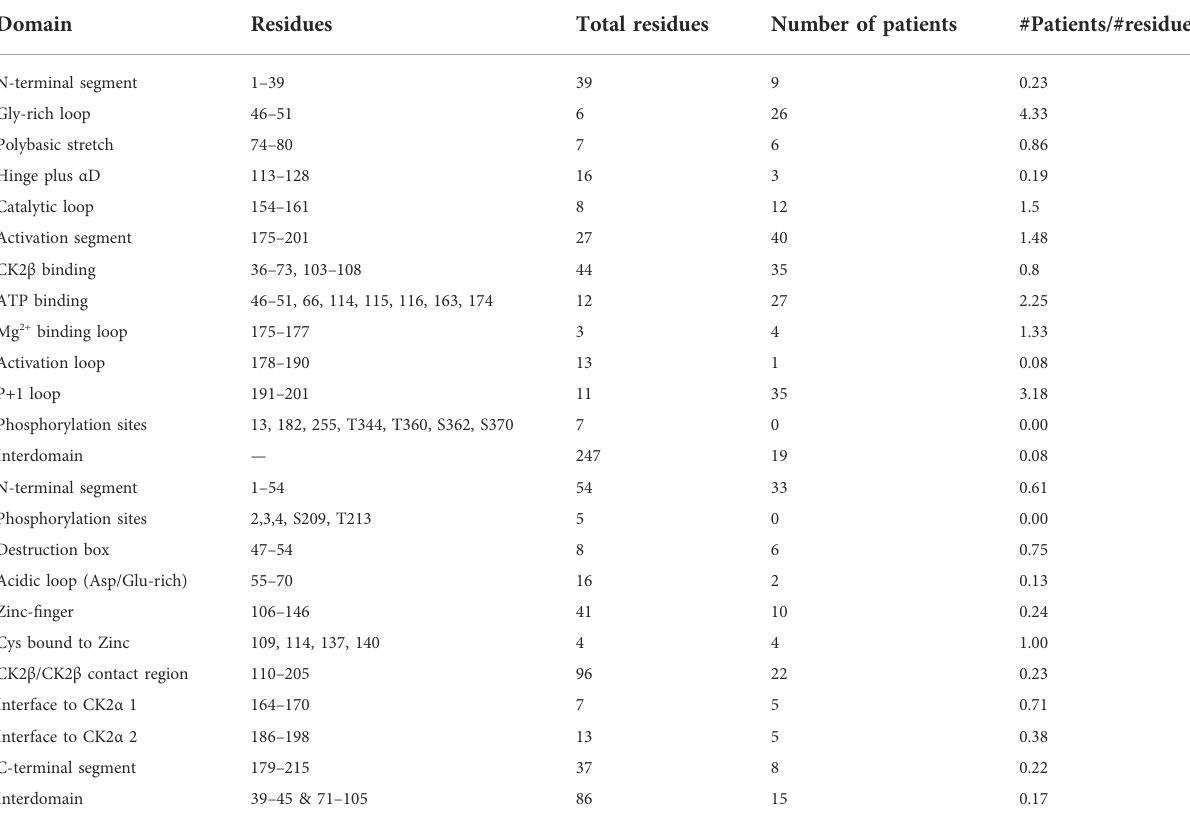
TABLE4NumberofmutationsperCK2 α andCK2 β functionalandstructuraldomain.TablesummarizesthenumbersofCK2 α (A)andCK2 β (B)mutants in each functional domain and the # mutations/# number of residues (excluding splice